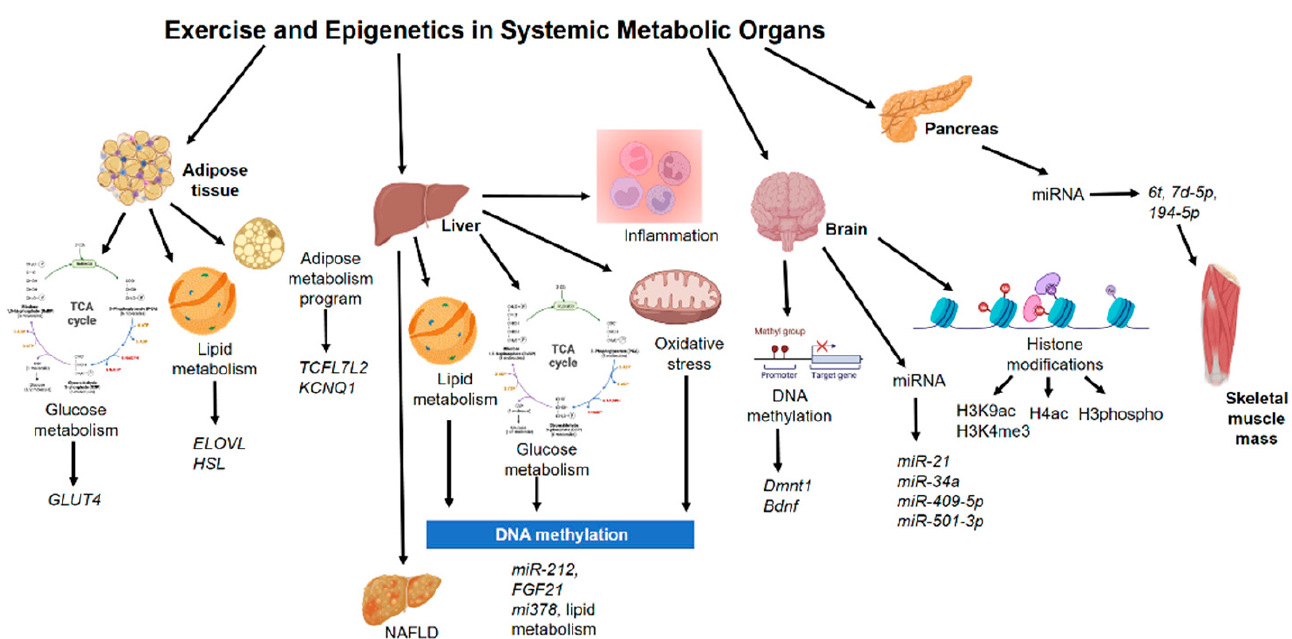
Figure 2. Epigenetics mechanisms in other non-muscle tissue during exercise. Abbreviations: Bdnf, brain-derived neurotrophic factor; Dmnt1, DNA (cytosine-5)-methyltransferase 1; ELOVL, Elonga- tion of very long chain fatty acids protein; FGF21, fibroblast growth factor 21; GLUT4, glucose trans- porter 4; HSL, hormone-sensitive lipase; KCNQ1, potassium voltage-gated channel subfamily Q member 1; NAFLD, non-alcoholic fatty liver disease; TCFL7L2, Transcription Factor 7-Like 2.